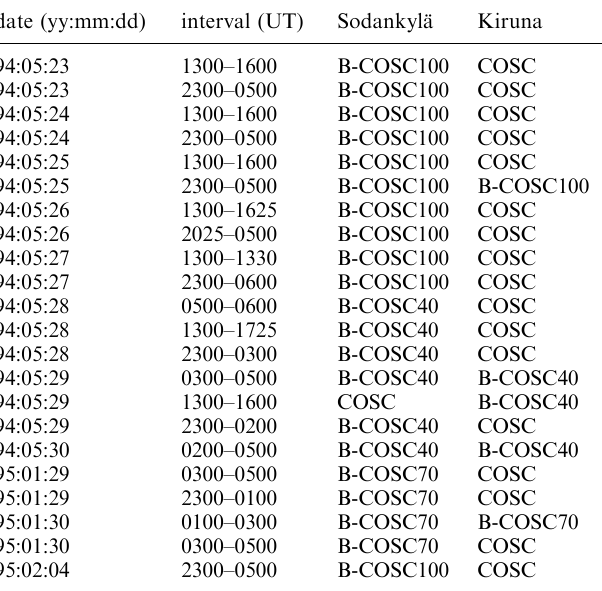
Table 2. Operations of the B-COSC experiment